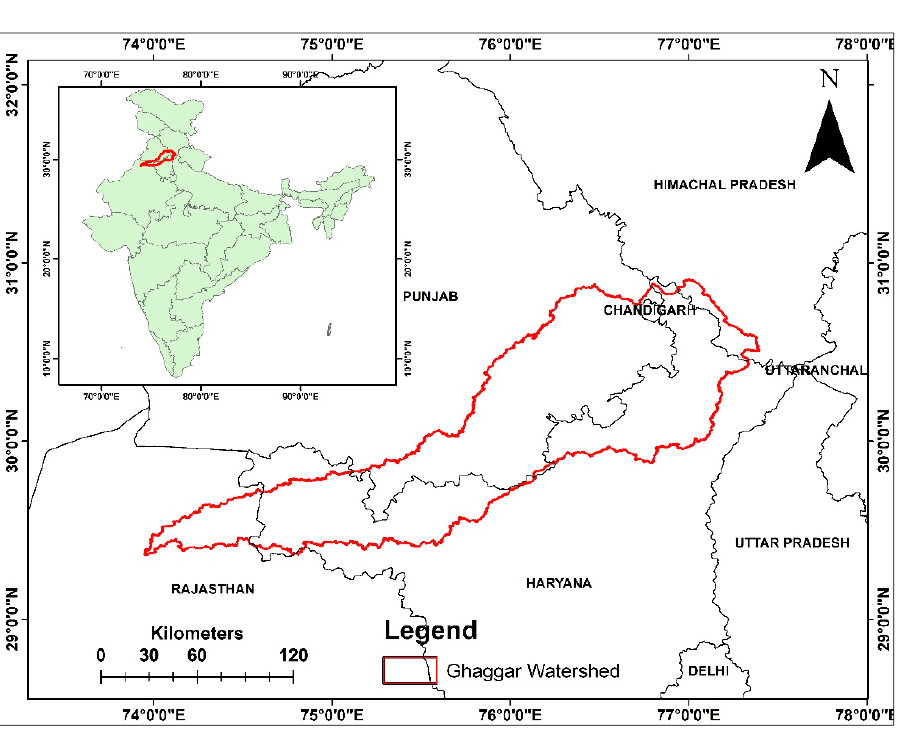
Figure 1. Location Map of the Study Area.